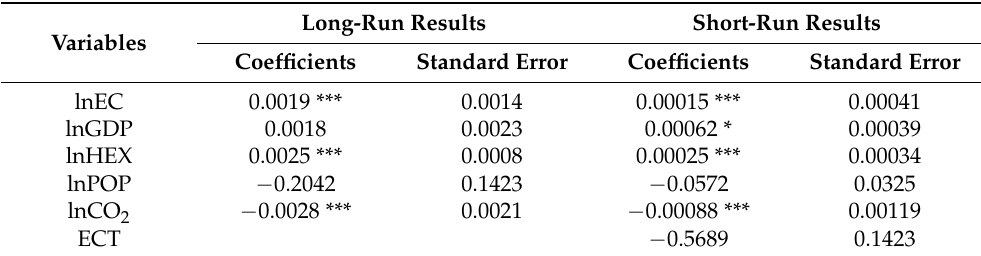
Table 7. Outcomes of CS-ARDL.